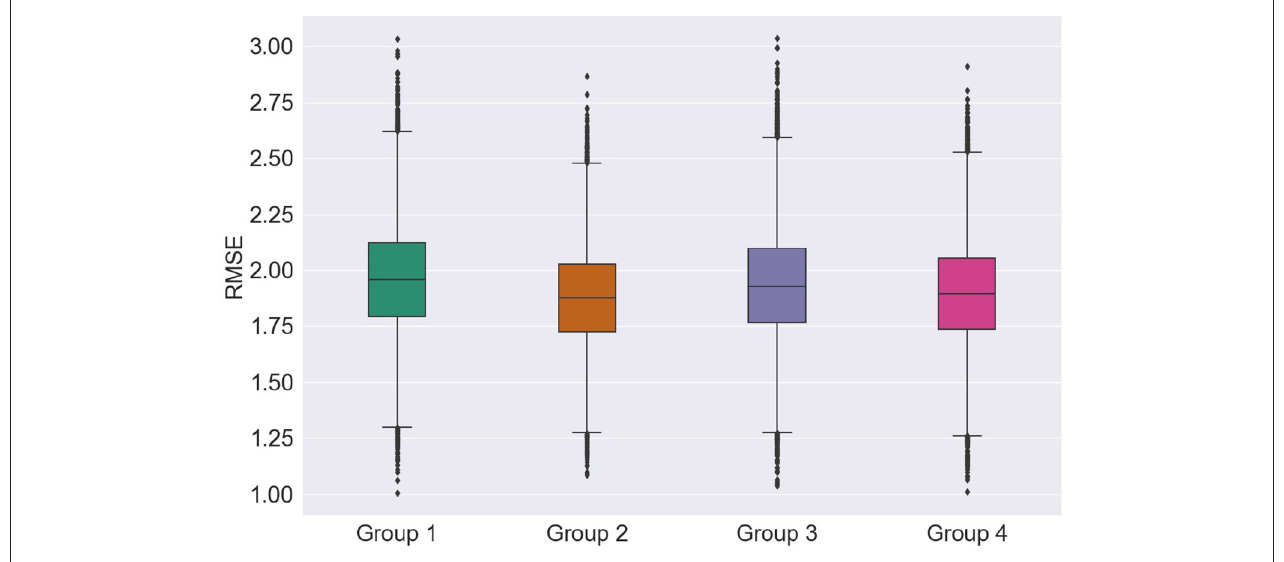
FIGURE 6 | Distribution of the RMSE scores according to the groups of